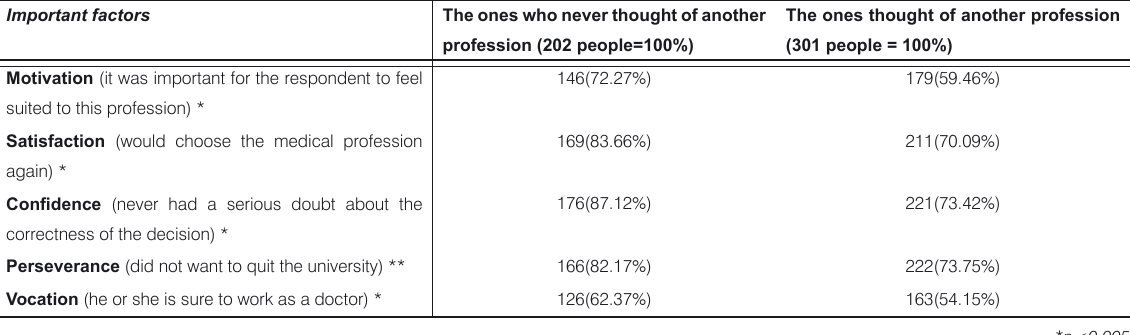
Table 6. The most significant differences between the students, regarding the thinking of another profession